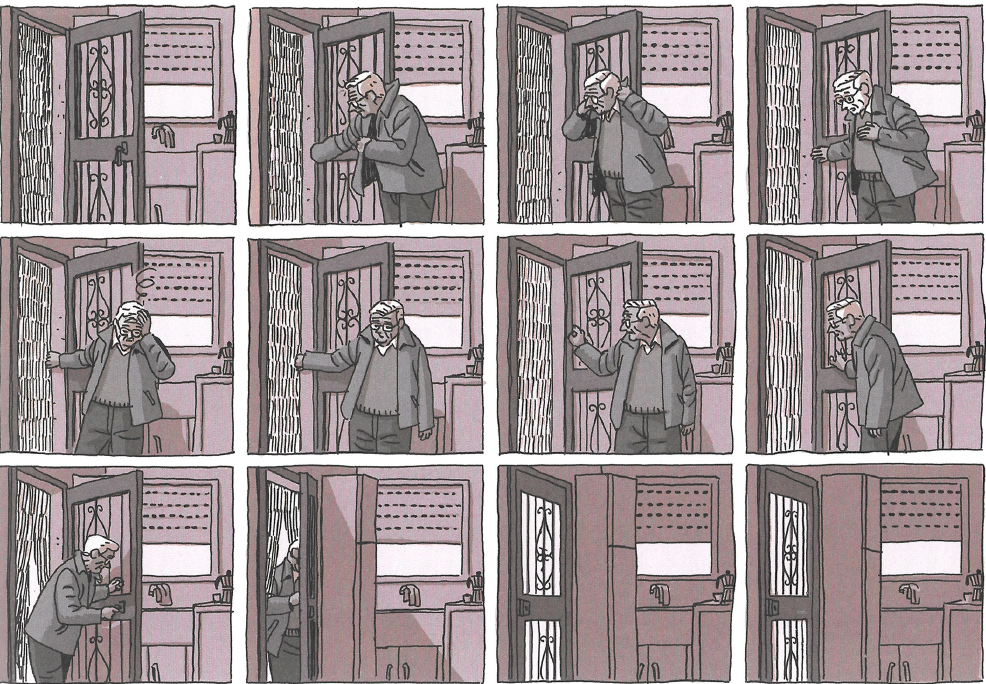
Fig. 9 The initial page of Paco Roca’s graphic novel with the departure of the father (Roca, 2016, p.